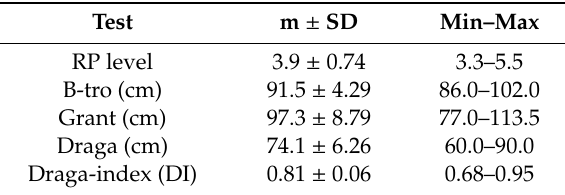
Table 2. Descriptive statistics of sports skill level, lower limb length, and sport-specific flexibility tests for 7b–9a RP climbers ( n = 31).